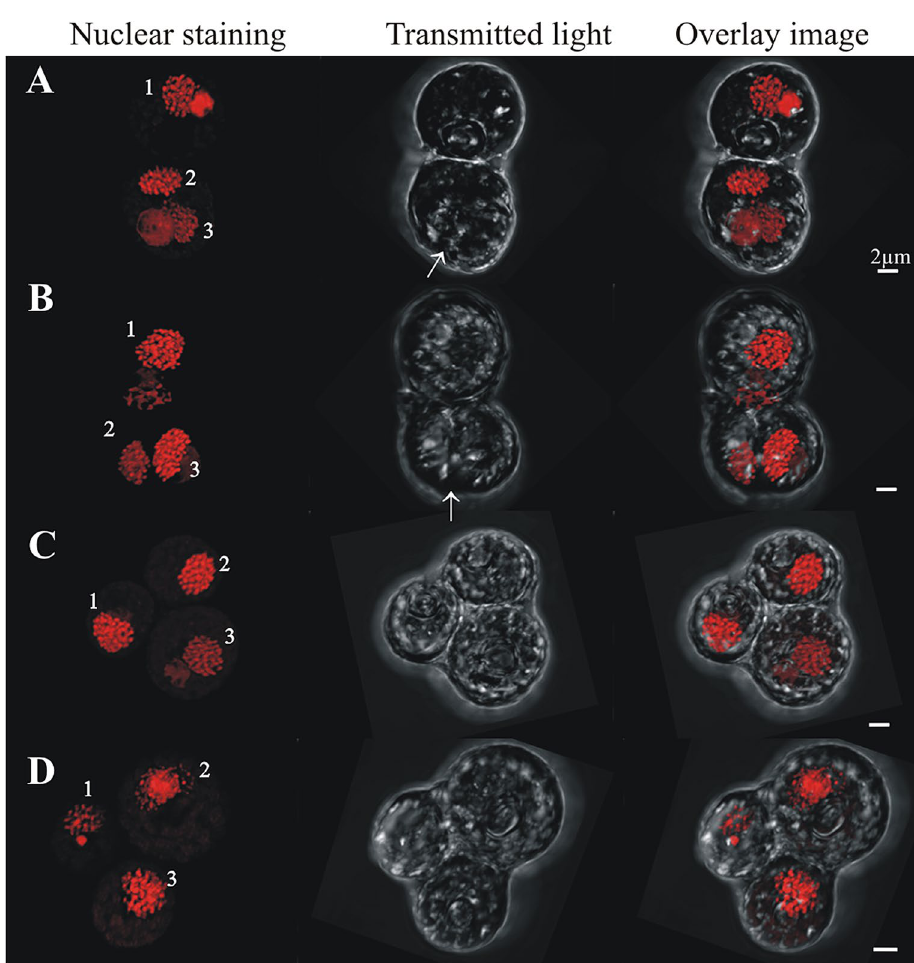
Figure 8. Confocal images of cells sorted in the (> 2C–4C) DNA content gate that have three nuclei and different numbers of lobes in their external morphology (lobes clearly visible in the transmitted light column). ( A , B ) cells with two lobes, one showing a dividing furrow (arrow); ( C , D ) three